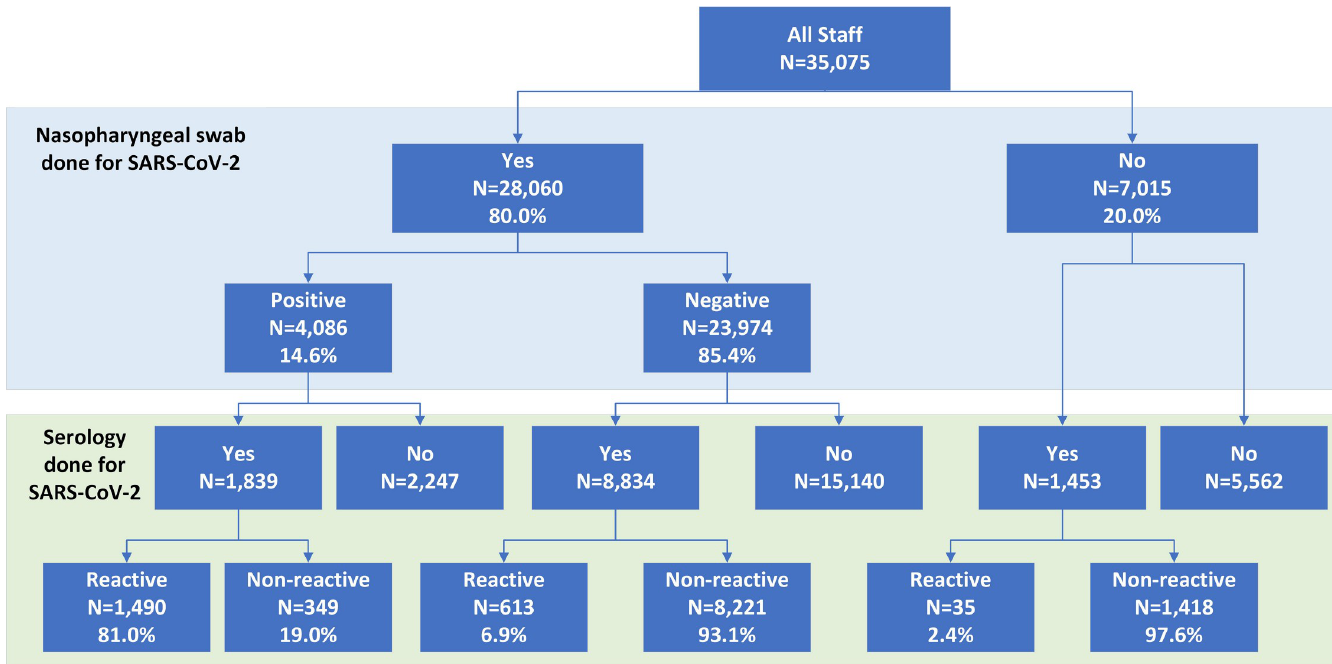
Fig 1. A flowsheet of all staff (full-time and contracted) who were tested for SARS-CoV-2